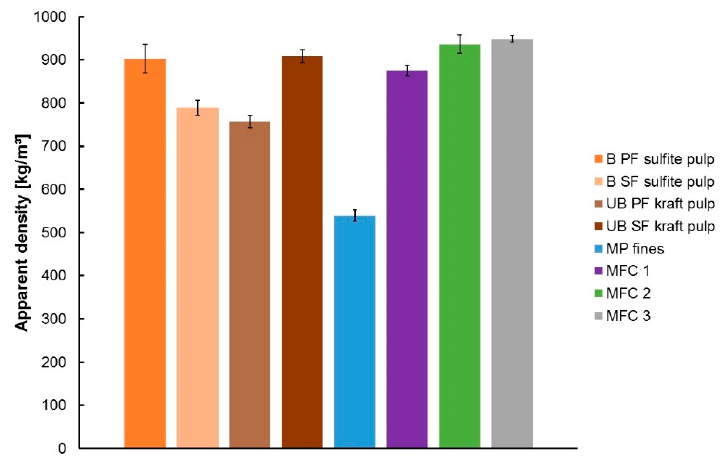
Figure 5. Apparent density of fines and MFC sheets.